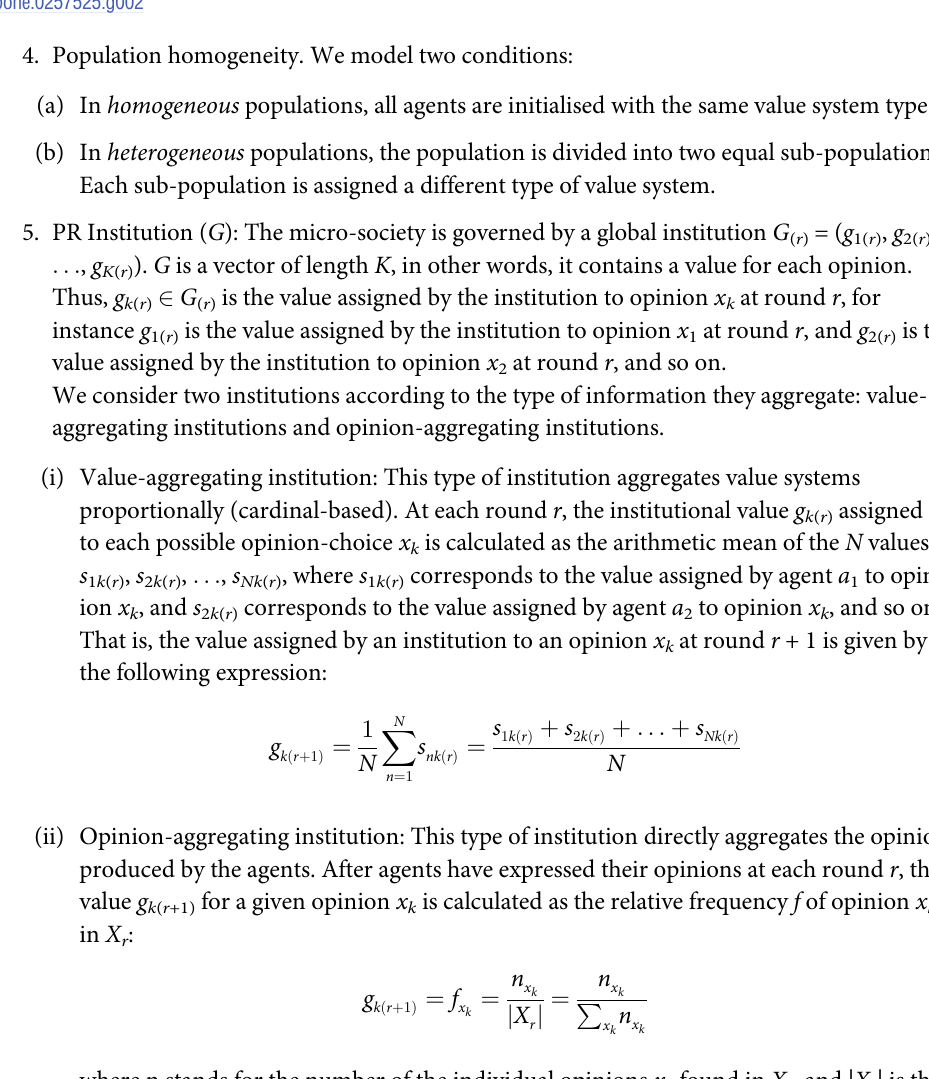
Fig 2. Three example value systems with 10 opinions each illustrating the three types of individual opinion value distribution.